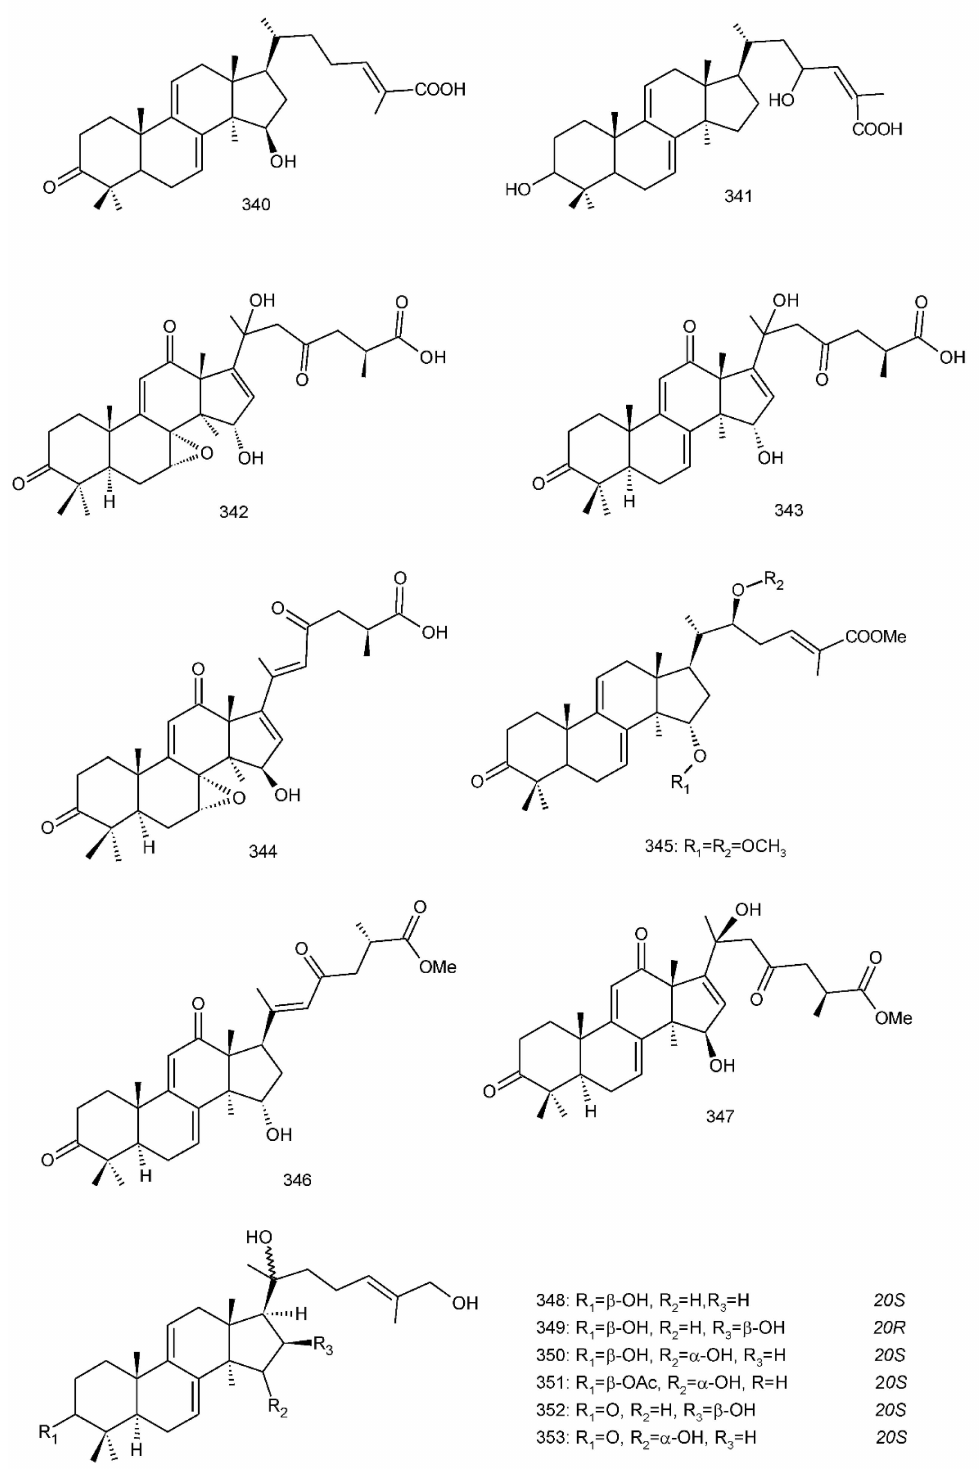
Figure 10. Chemical structures of several ∆ 7(8),9(11)-triterpenoids ( 254 – 353